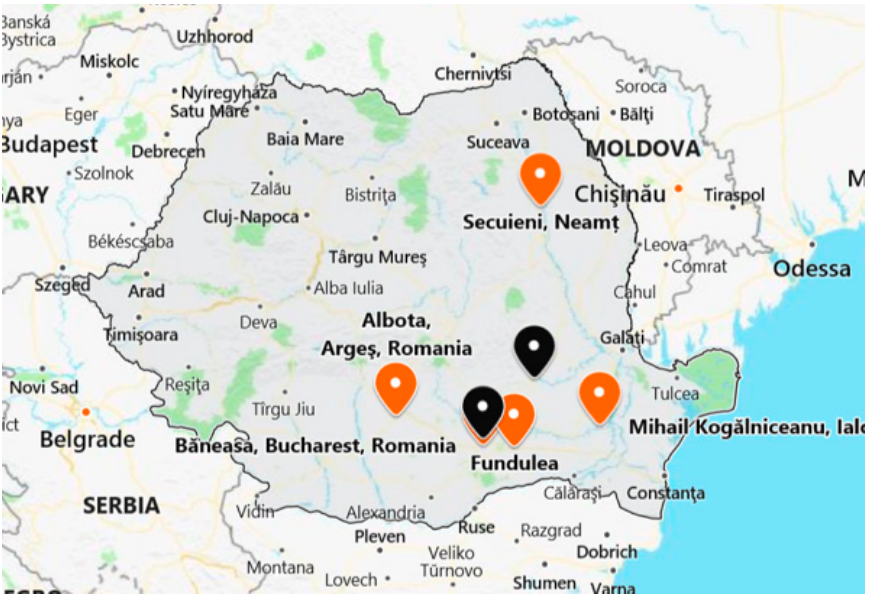
Figure 1. Monitored locations by honeybee colonies to field-realistic exposure to neonicotinoids in Romania.